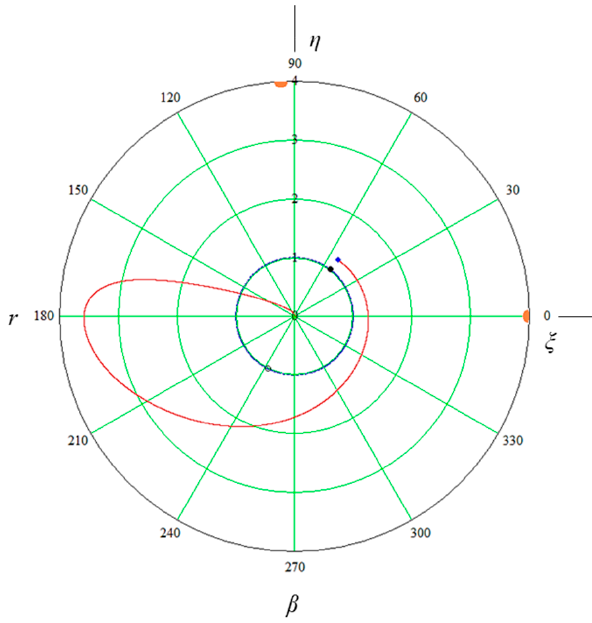
Figure 2. The trajectory of the SC obtained from solving the problem of the first stage; the polar angle reading direction coincides with the inertial direction of the main axis of the coordinate system ξСη ( ζ ), the position of which at the time of the mission start coincides with the direction to the Sun. The red solid line shows the flight trajectory; dotted blue—the Moon’s orbit; the black unfilled circle characterizes the position of the Moon at the time of launch; the black solid circle is the position of the Moon at the moment when the spacecraft reaches the given vicinity of the libration point L 2 ; the blue diamond defines the position of the libration point; the filled orange circle describes the position of the Sun at the moments of the start of the flight and reaching the vicinity of L 2 , respectively.